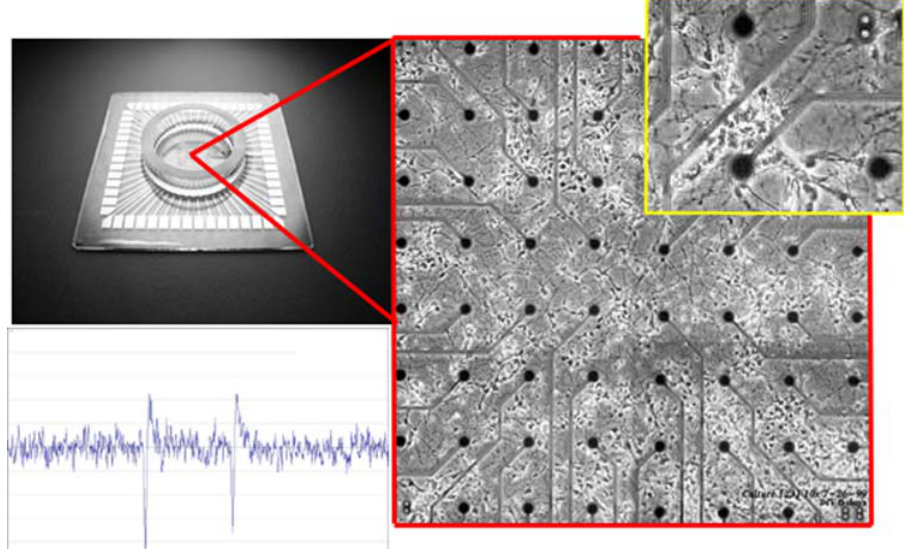
Figure 1. Living Rat Cortical Neurons on a 60 Electrode Microelectrode Array (MEA) from MultiChannel Systems. A 60 electrode MEA (upper left) used to measure neural activity from a small network of cultured neurons. The upper right corner shows a magnified view of the array consisting of an 8 6 8 grid of 60 electrodes with living rat cortical neurons at 6 days in vitro. Each electrode is spaced 200 um apart and measures the extracellular potential of neurons nearby the electrode. Example of an extracellular action potential measured with a single electrode (window scale 100 ms 6 50 uV). Neurons on these arrays are spontaneously active producing synchronized bursts of activity throught their lifetime (up to two years).